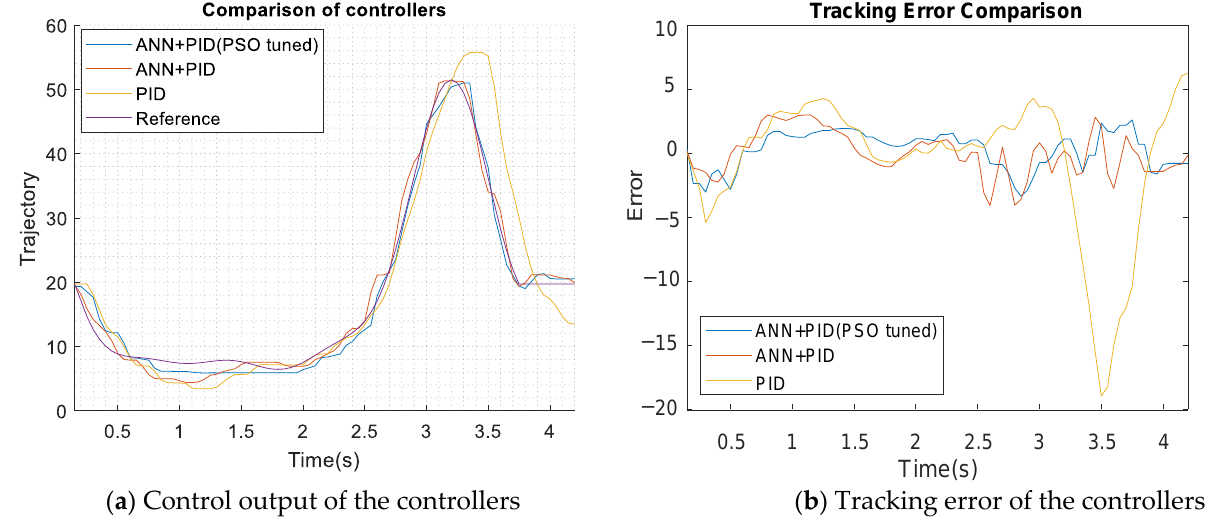
Figure 22. PSO tuned controller performance comparison.